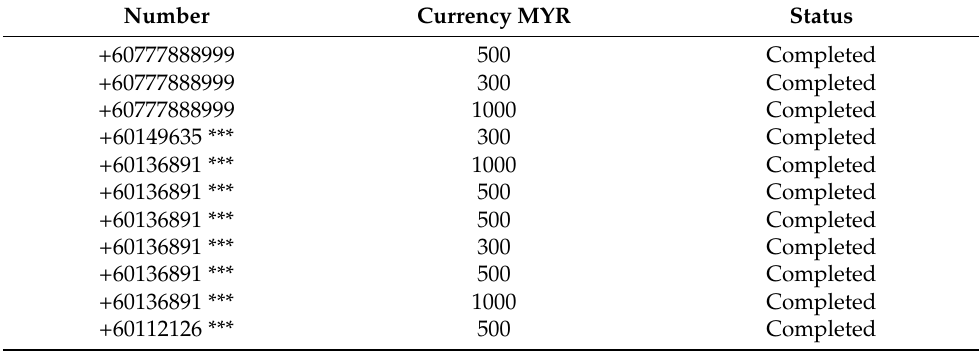
Table 7. Money transaction results.